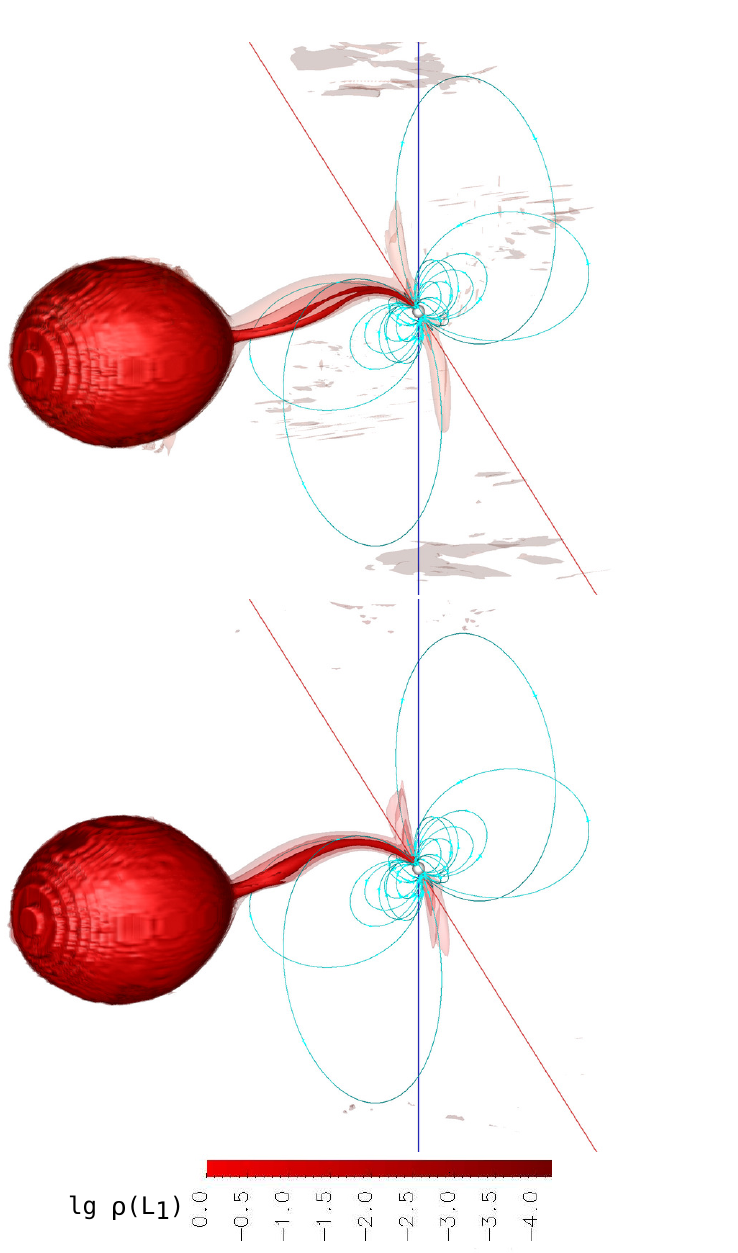
Figure 5. The same as Figure 4 but for Variant 3 ( upper panel) and Variant 4 ( lower